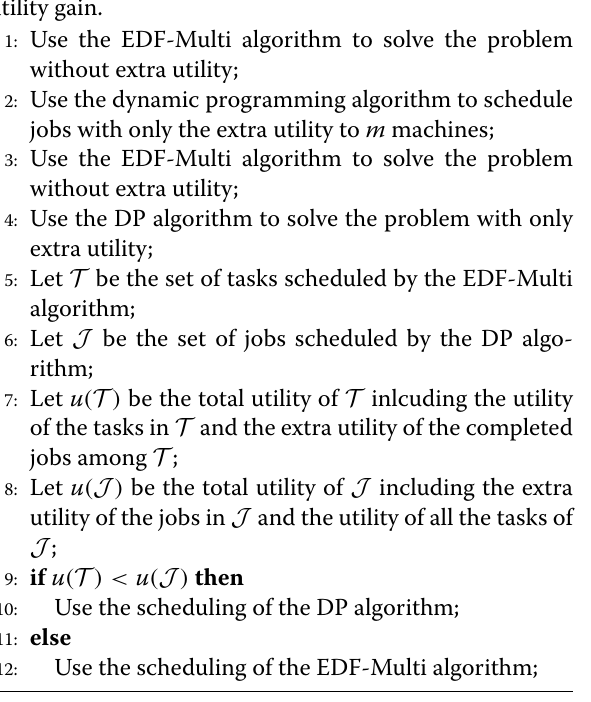
Algorithm 5 APPXm